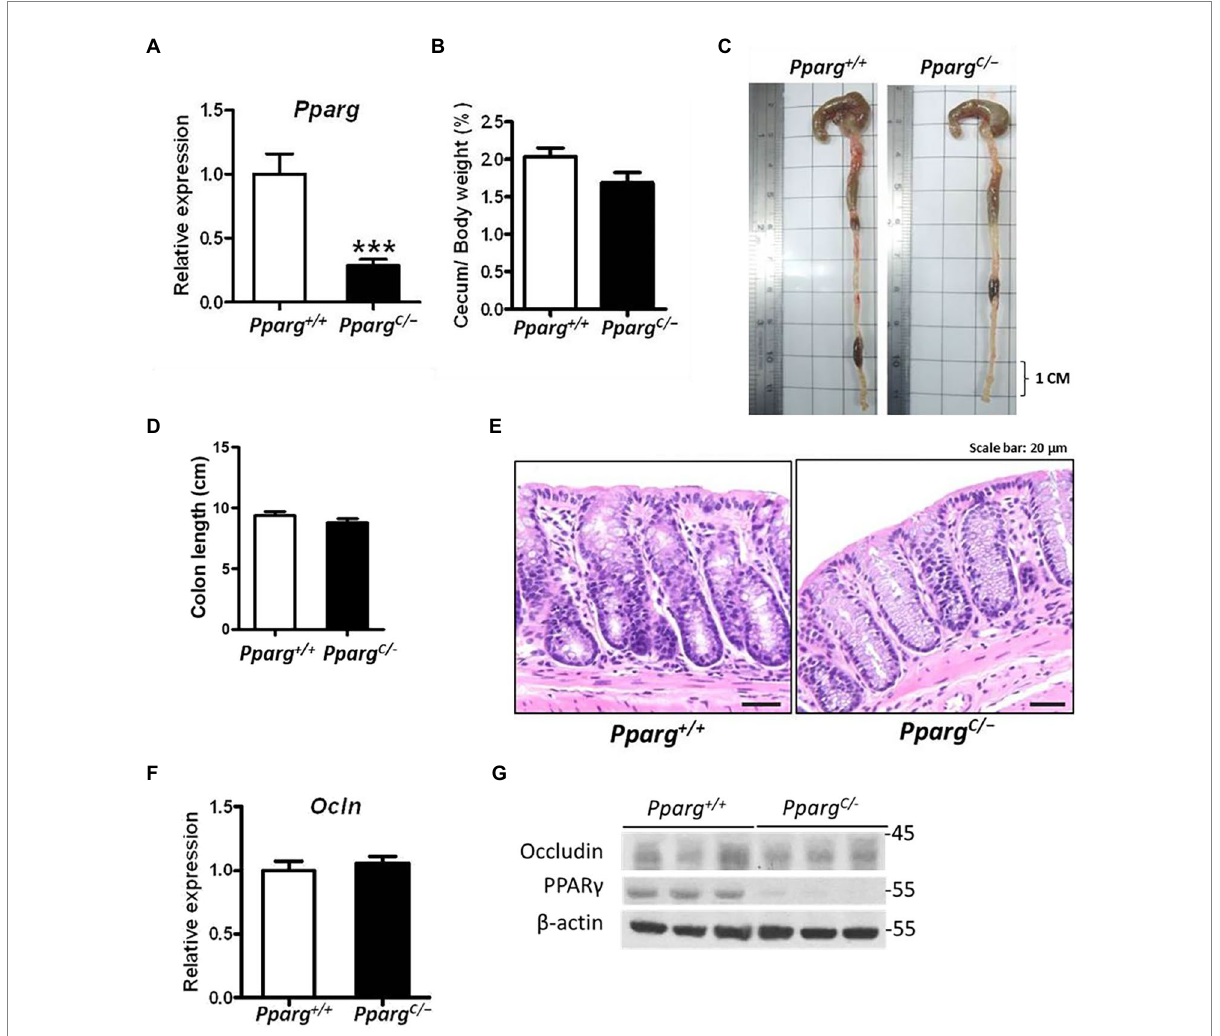
FIGURE 3 Differences in colonic physiology between wild-type ( Pparg +/+ ) and PPAR- γ deficient ( Pparg C/ − ) mice. (A) Real-time PCR of PPAR- γ expression in colonic tissue. (B) Change of cecum weight divided by body weight. (C) Gross view of the colon. (D) Quantification of colon length of Pparg +/+ and Pparg C/ − mice without CDI. (E) Normal histological pattern and staining for hematoxylin and eosin (H&E) of paraffin-embedded colon tissue prepared from Pparg +/+ and Pparg C/ − mice. (F) Real-time PCR of occludin expression in colonic tissue. (G) Western blot analysis of PPAR- γ and occludin expression in colonic tissue of Pparg +/+ and Pparg C/ − mice. Values are expressed as mean ± SEM (***, p < 0.001 relatives to control group). All data are representative of three independent